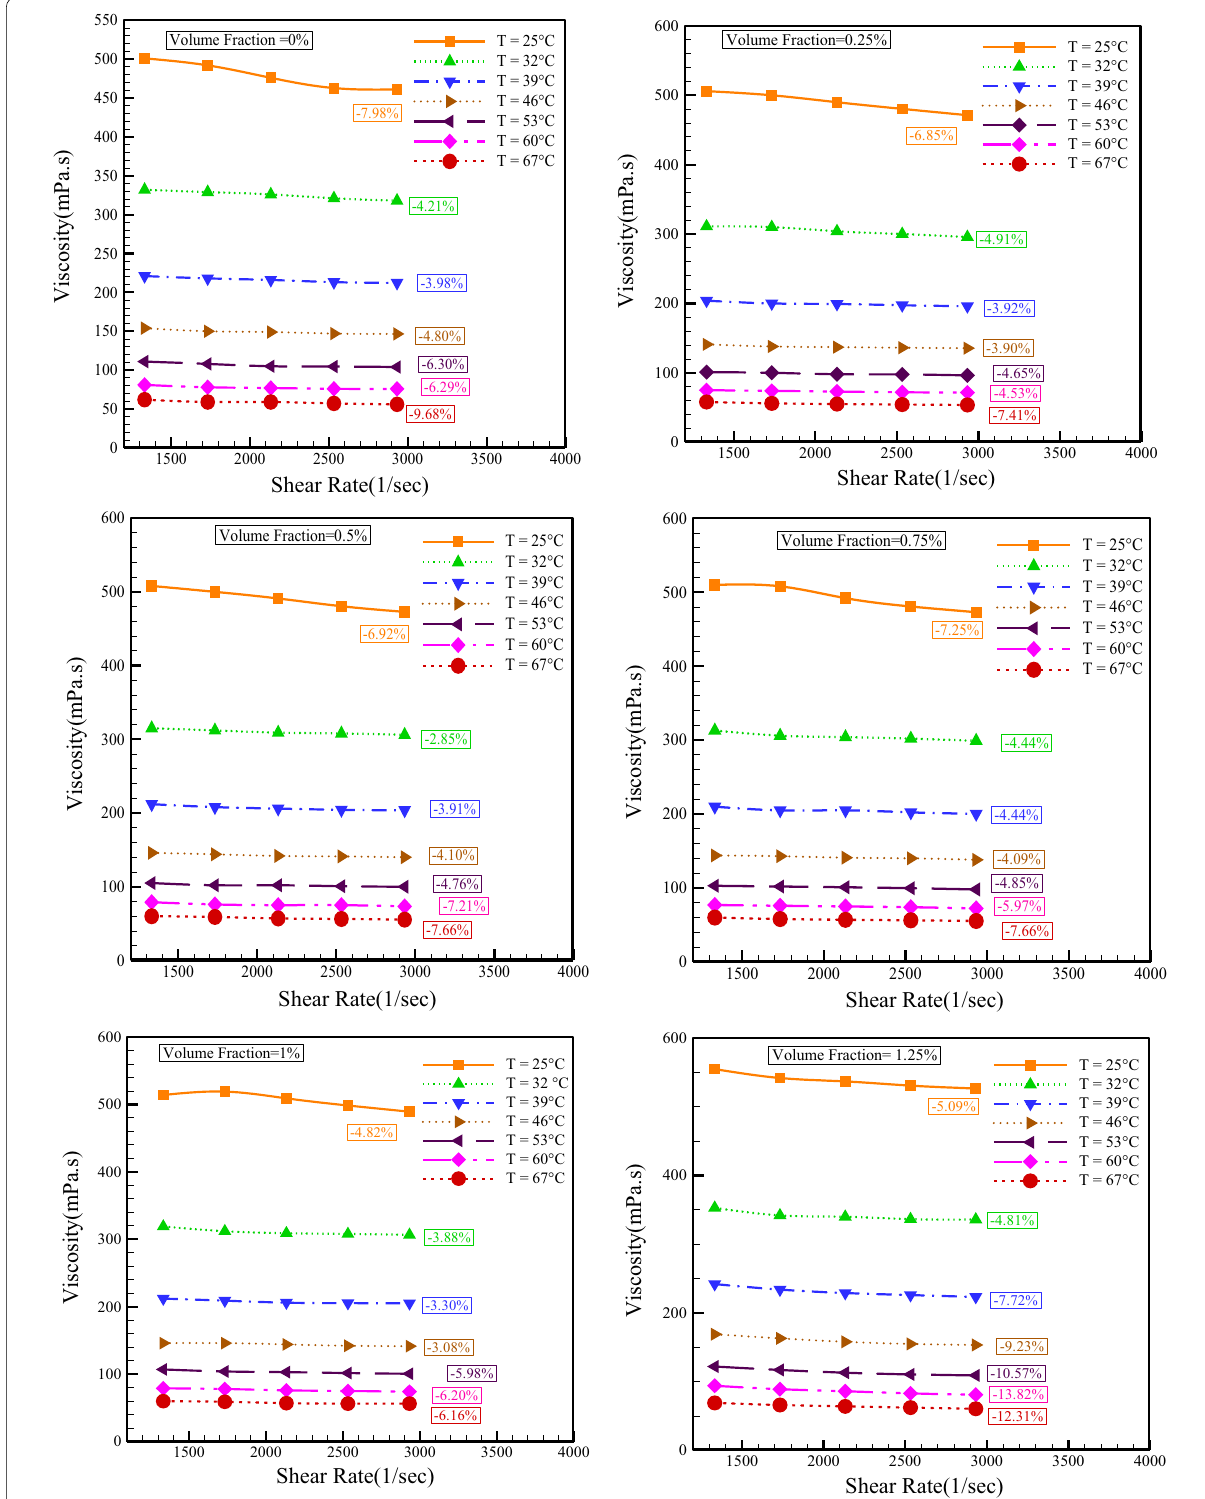
Fig. 8 Changes in dynamic viscosity according to shear rate in different